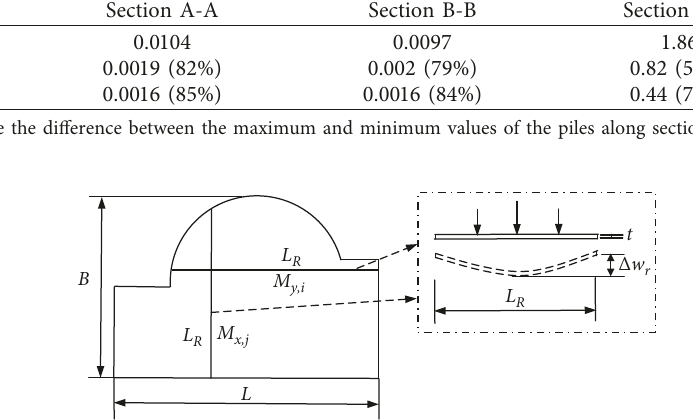
Figure 11: Sketch of integral bending moment calculation.